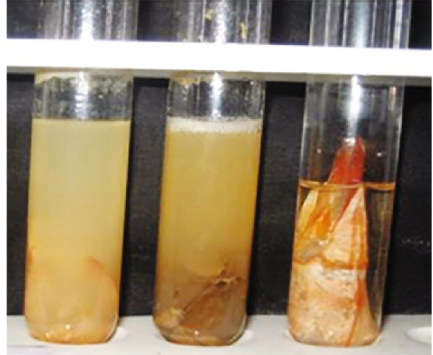
Figure 2: Shrimp shell degradation e ff ects by partial puri fi ed chitinase enzyme produced by wild strains of B . licheniformis (SSCL-10). (1) Shrimp shells alone without Bacillus licheniformis SSCL10. (2) Shrimp shells with Bacillus licheniformis SSCL10 for 6 days. (3) Shrimp shells with Bacillus licheniformis SSCL10 for 12